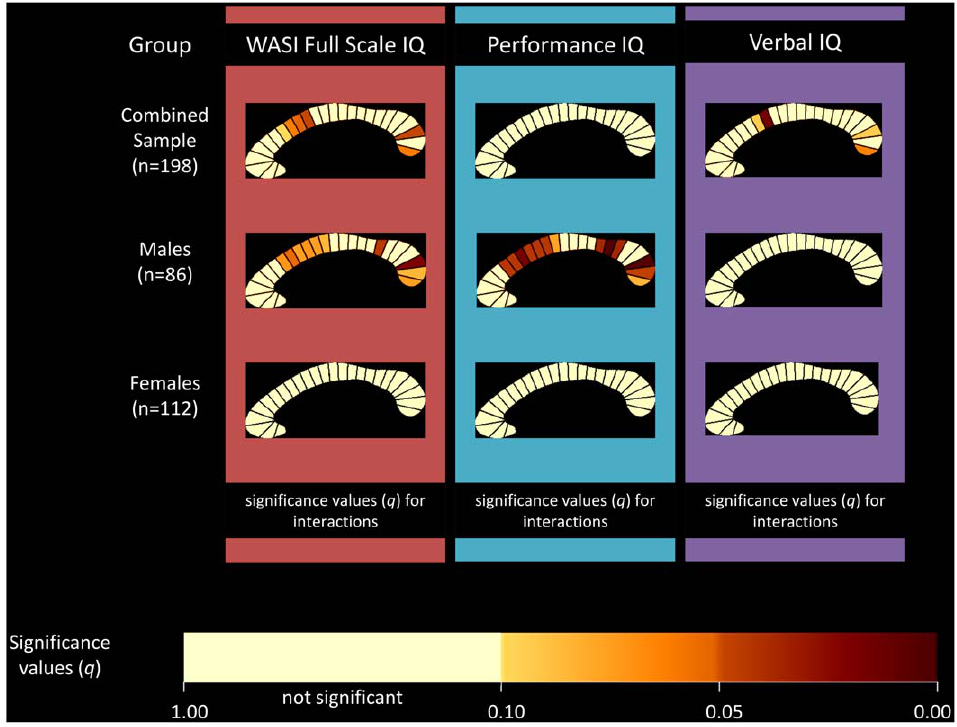
Figure 7. Age by IQ interaction: combined sample and sample partitioned by gender. A general linear model was used with an age by IQ interaction term to examine the interaction between IQ and age as a continuous variable. Significance values are displayed as callosal maps with Full- Scale IQ results shown in the first column, Performance IQ results in the second column, and Verbal IQ results in the third column. Values for the combined sample are shown in the first row and results for males and females are shown in the second and third rows respectively. The color bar encodes the level of significance for the interactions.